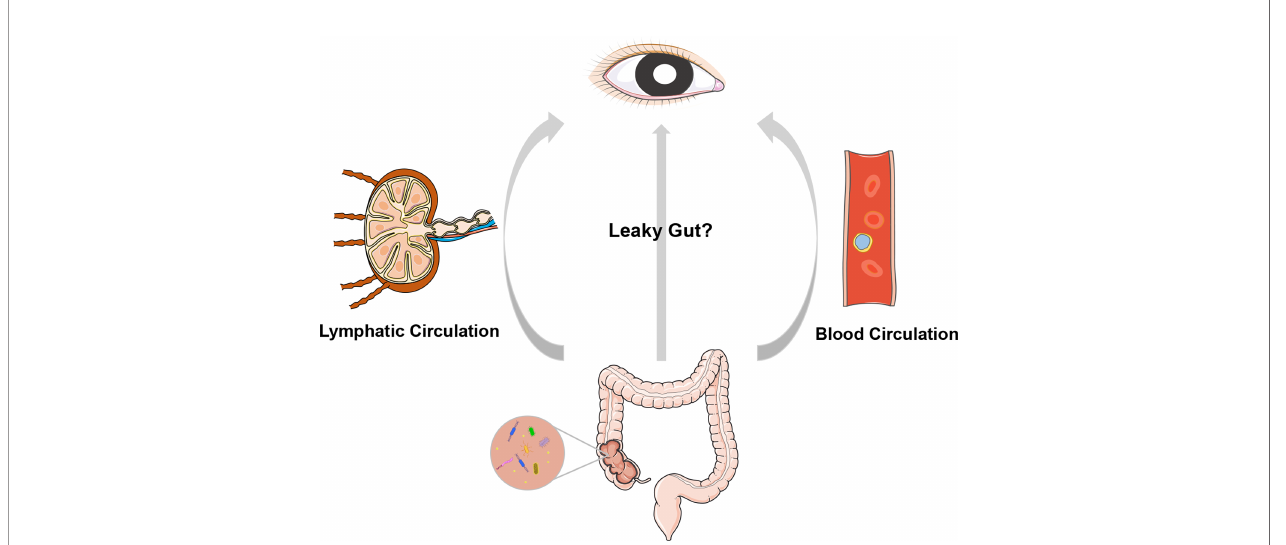
FIGURE 1 | A cartoon illustration of the “ gut-eye axis ” . Dysbiosis of the intestinal microbiota of disruption in the intestinal barrier may result in translocation of the intestinal bacteria and/or their metabolites into circulatory system and lymphatic system, and further impact the eye, which is remotely located from